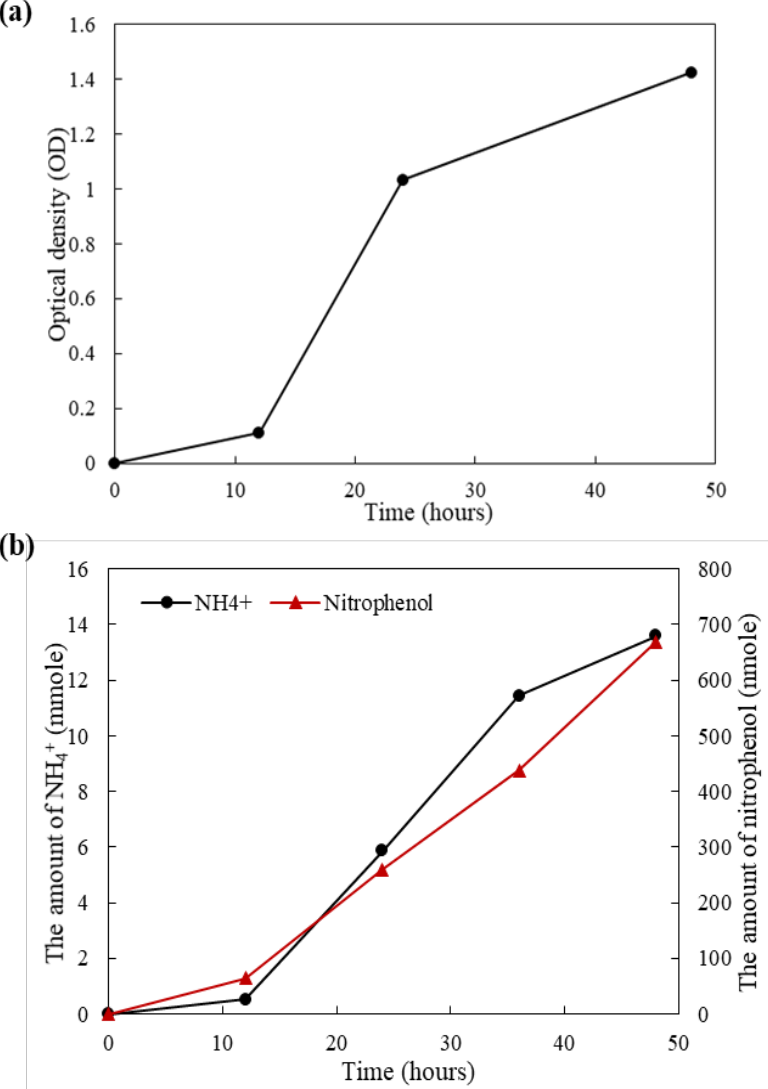
Figure 1. Changes in ( a ) optical density and ( b ) the amounts of produced NH 4+ and nitrophenol of bacterial culture solution over time.